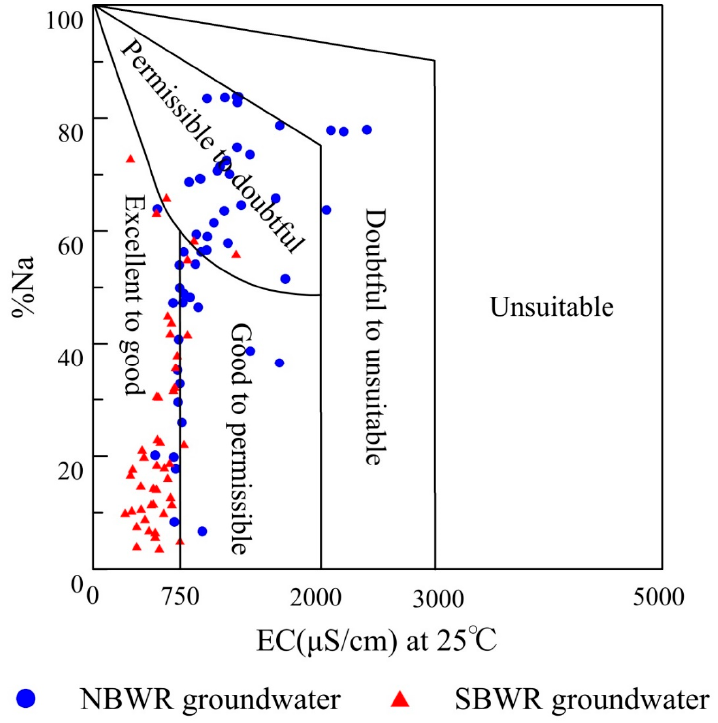
Figure 6. USSL diagram for assessing irrigation water quality.